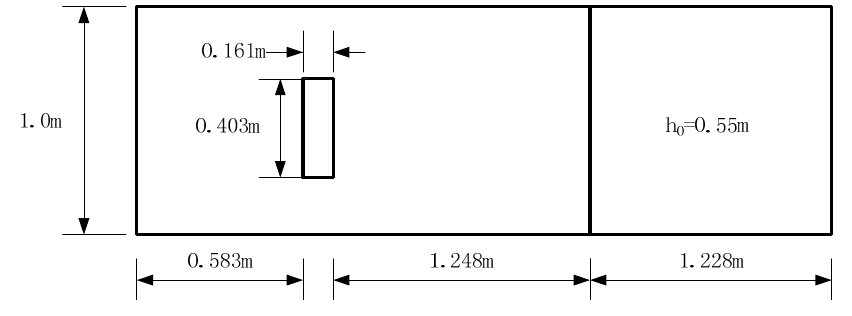
Figure 4. Schematic layout of dam break flow experiment with a rectangular obstacle [21].